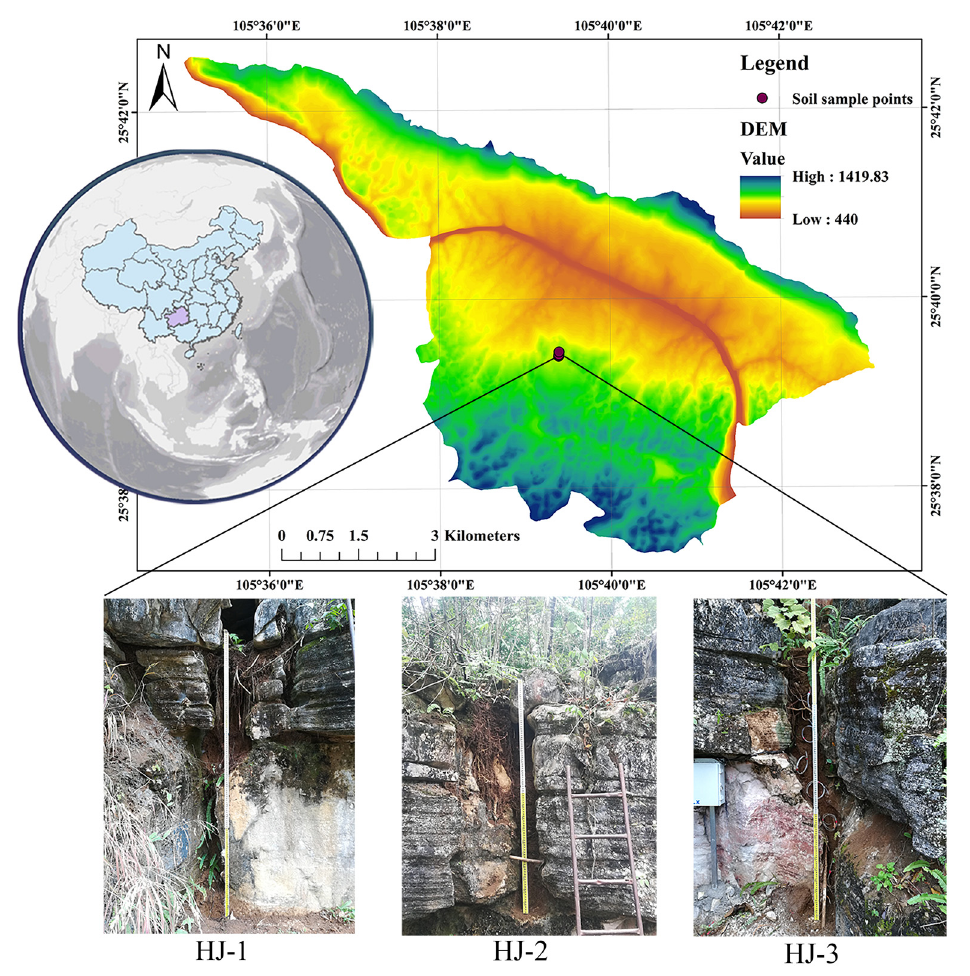
Figure 1. Locations of the study area and fissure soil sampling sites.